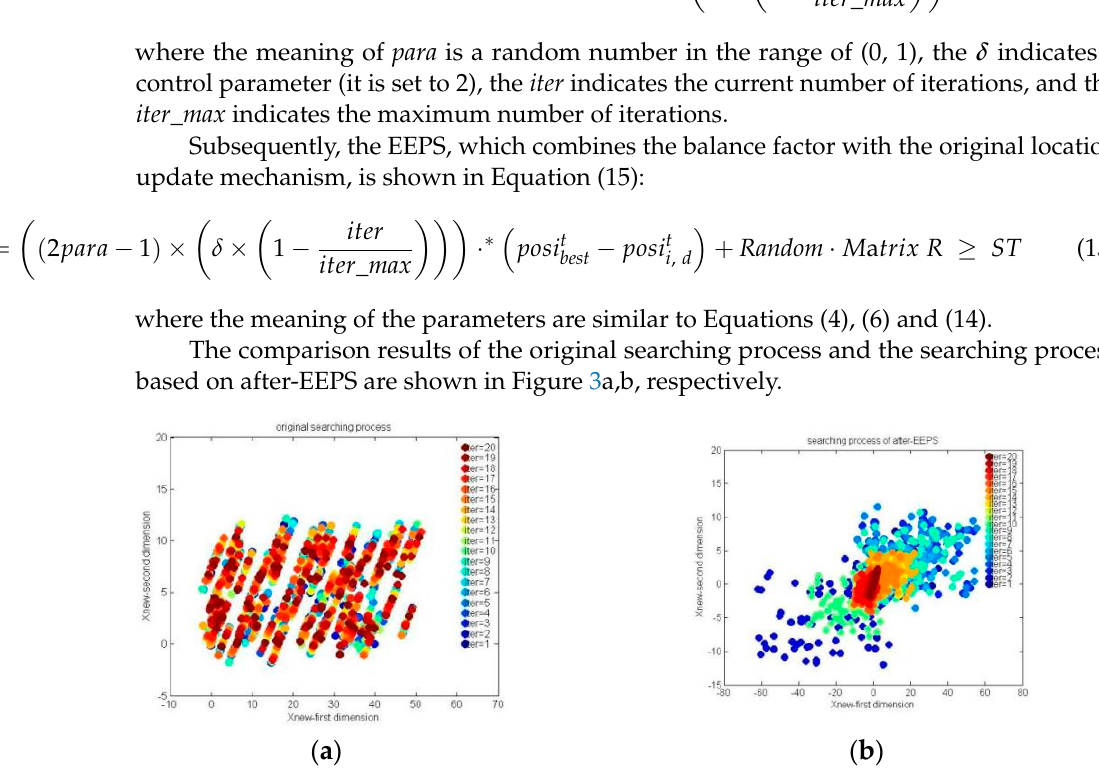
Figure 3. The comparison result figures of searching processes. ( a ) the original searching process; ( b ) the searching process based on